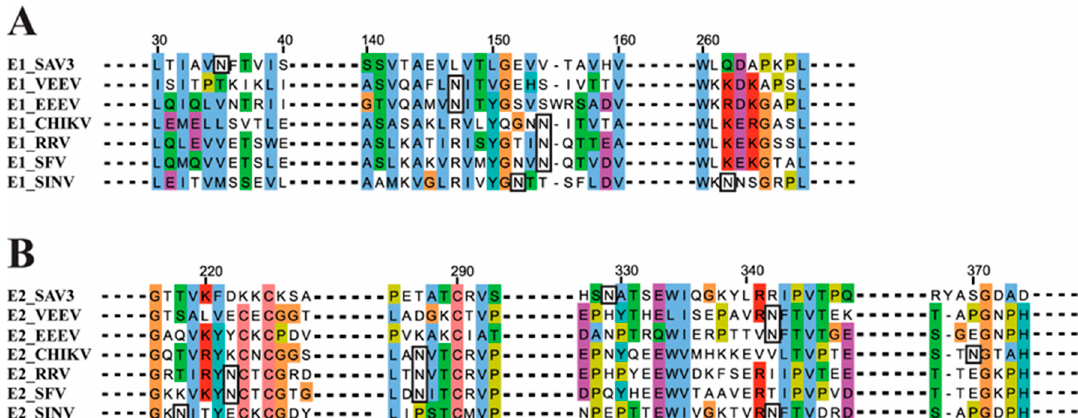
Figure 1. Location of the N-glycosylation sites in SAV3 E1 and E2. Multiple sequence alignment of ( A ) SAV3 E1 and ( B ) SAV3 E2 with the corresponding protein sequences from a selection of other alphaviruses. Predicted N-glycosylation sites are shown in black boxes. Except for SAV3, the sites of N-glycosylation in E1 and E2 have been verified by structural studies [32–40]. VEEV = Venezuelan equine encephalitis virus (P09592), EEEV = Eastern equine encephalitis virus (ANB41743), CHIKV = Chikungunya virus (AEA10291), RRV = Ross River virus (P08491), SFV = Semliki Forest virus (NP_819008, NP_819006) and SINV = Sindbis virus (CAA24684). Dotted lines in bold indicate the sequence sections removed for display purposes.